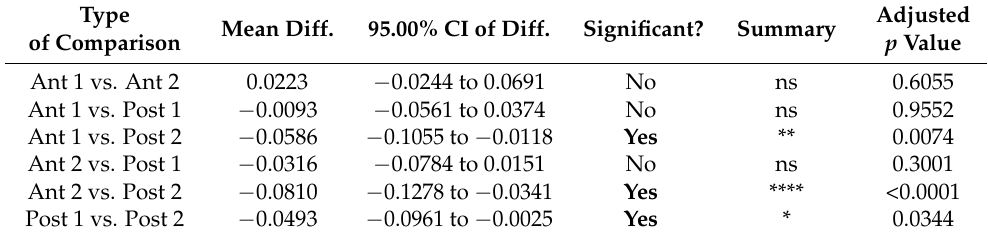
According to Tukey’s multiple comparison test (Table 6 and Figure 5), the comparisons between different regions/levels of the superficial fascia of arm and of forearm showed sta- tistically significant differences, with an alternating trend between the anterior and posterior region of the superficial fascia of the arm and of forearm (Table 6). Regarding the posterior region/levels, the superficial fascia of the arm had a greater thickness (0.45 ± 0.10 mm) than the superficial fascia of the forearm (0.40 ± 0.10 mm) (Figure 5 and Table